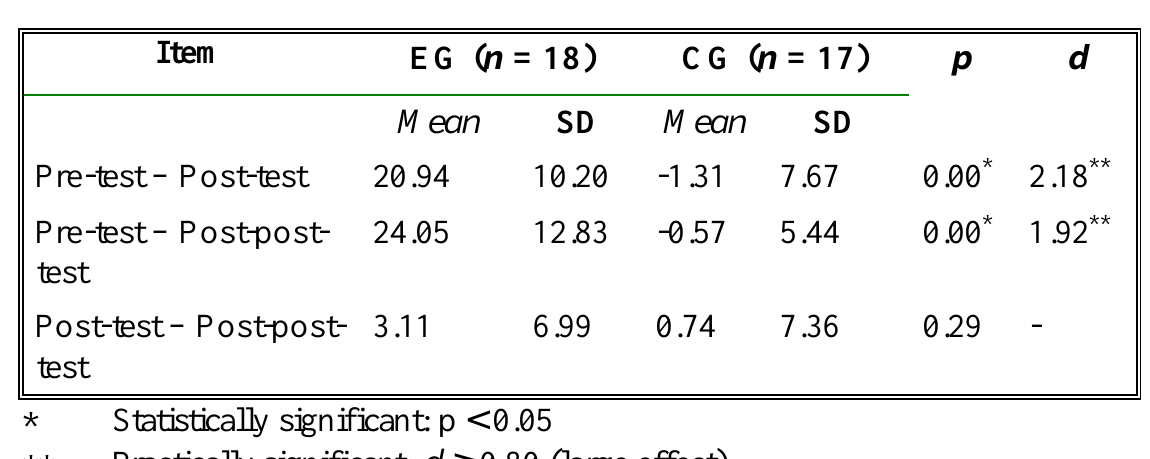
Table 6 Significance of differences between the pre- and post-tests of the experimental and control groups on the knowledge